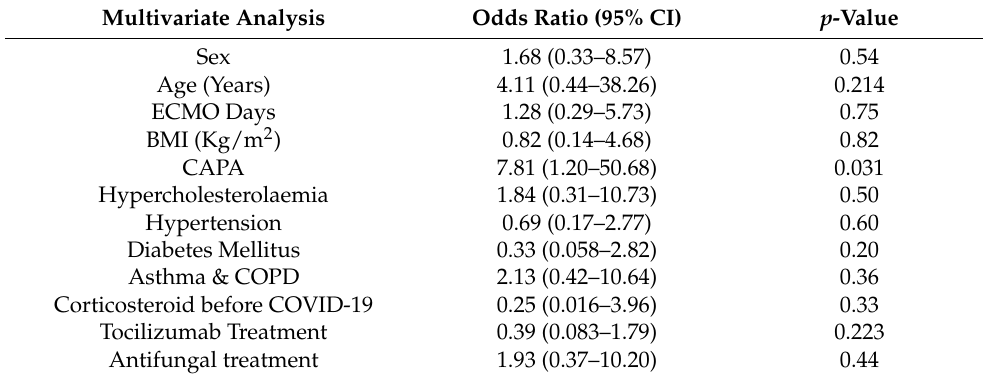
Table 5. Risk factors for non-survivors (death) in COVID-19 patients on ECMO treatment.